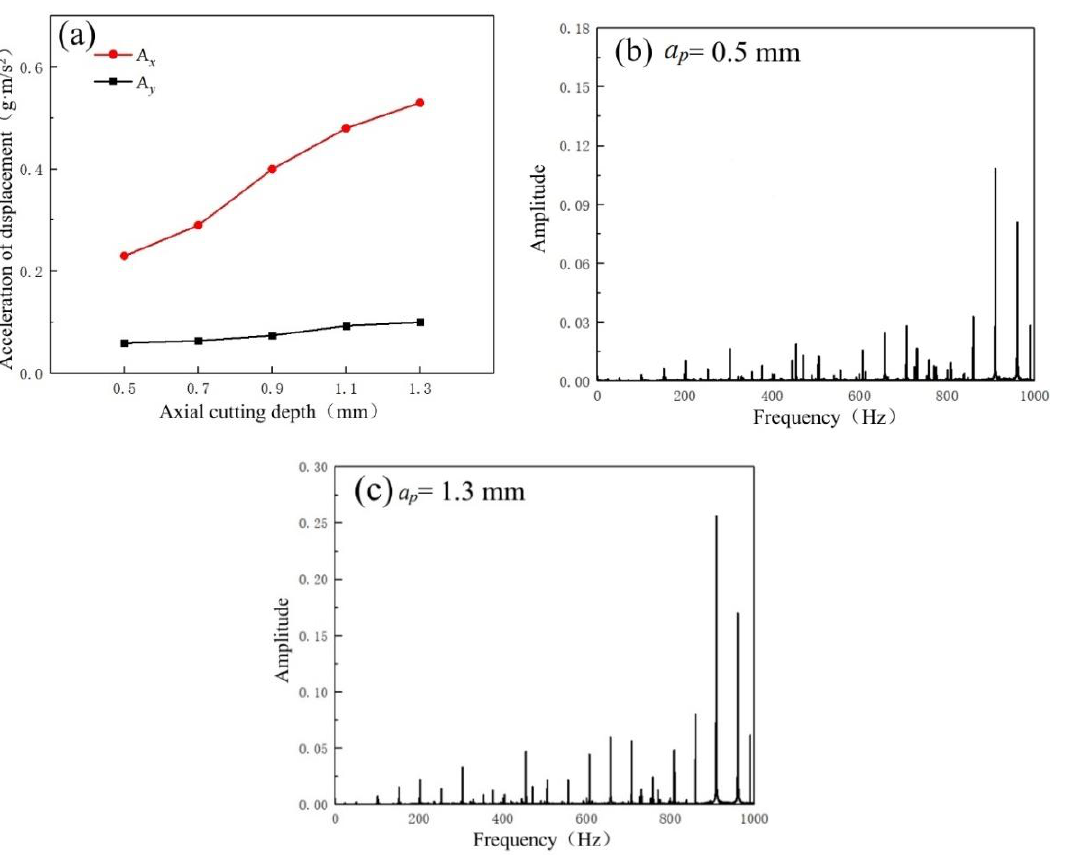
Figure 17. ( a ) Variation trends of displacement acceleration at different axial cutting depths. The frequency domain distribution of tool-moving direction: ( b ) a p = 0.5 mm; ( c ) a p = 1.3 mm.